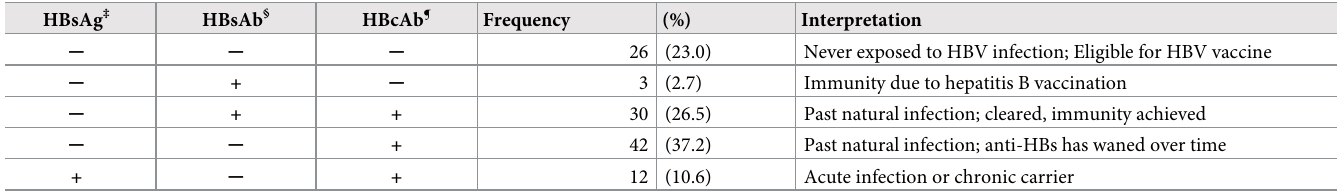
Table 4. Hepatitis B serological markers profiles among HIV-positive female sex workers in Togo (n = 113†). HBsAg ‡ HBsAb § HBcAb ¶ Frequency (%)